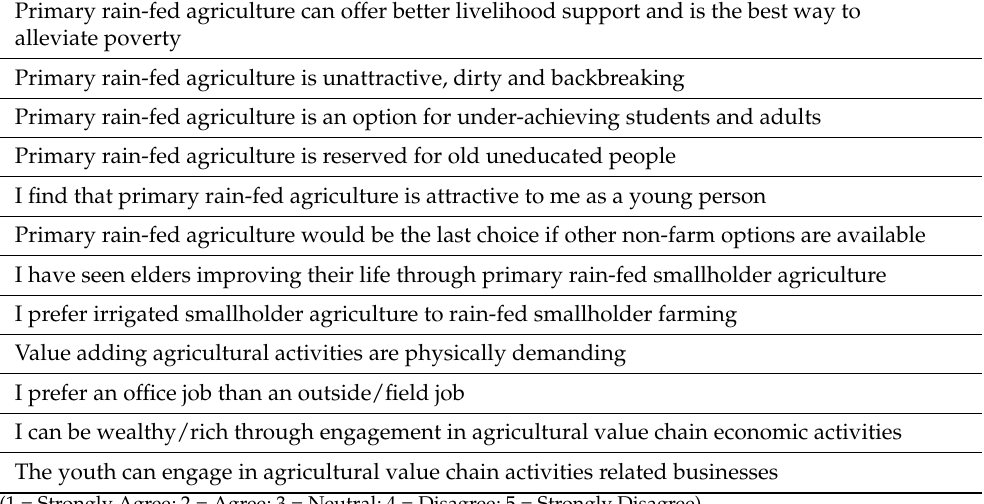
Table 2. Statements used to determine perception dimensions of youth.